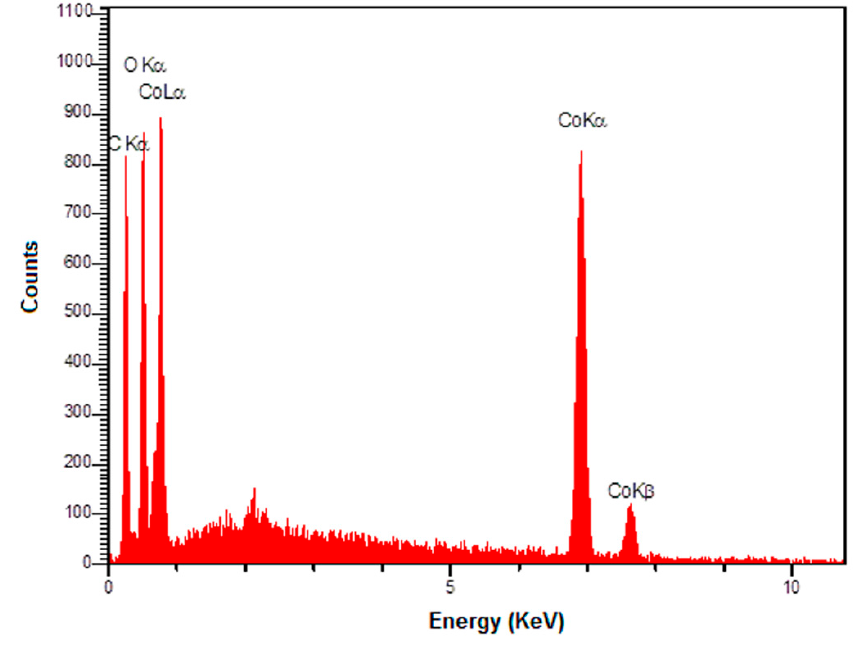
Figure 3. The EDS spectrum of graphene-Co 3 O 4 nanocomposite.